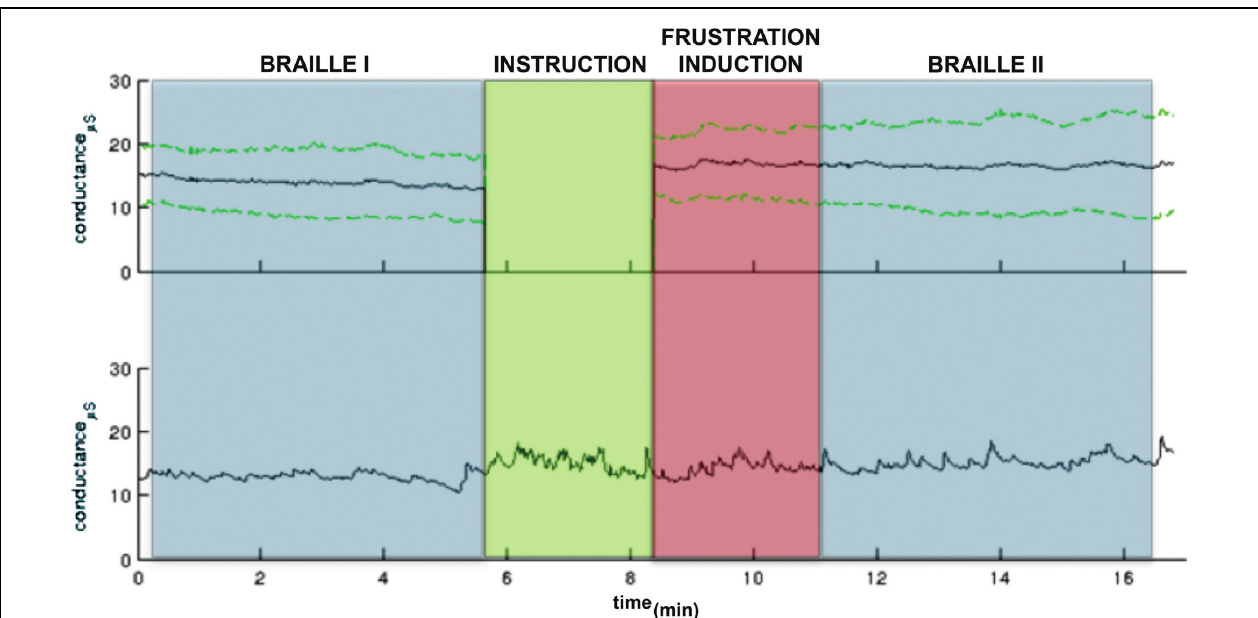
FIGURE 2 | A GSR observed in the pre-test pilot study. The colors indicate particular part of the experiment: Braille I and II (blue), the instruction (green) following the frustration induction (red). The upper panel: the grand mean GSR (black line) and ± standard deviation lines (green dashed lines). The green part (instruction) was excluded from group analysis due to variable length. The activity only in particular task parts was calculated. The lower panel: An example GSR time course.